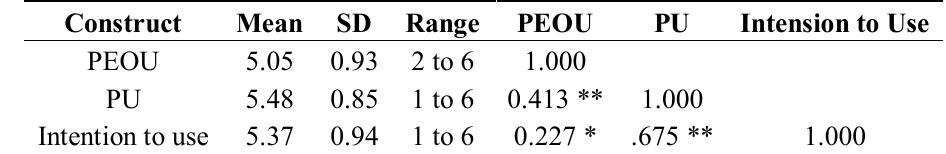
Table 5. Correlation